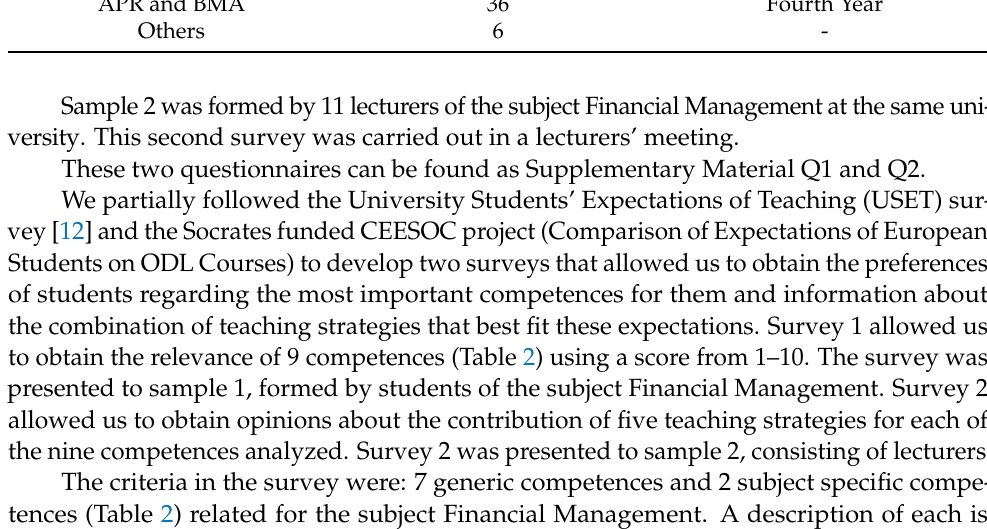
Table 1. Degree and course of the students. Degree Participants Stage